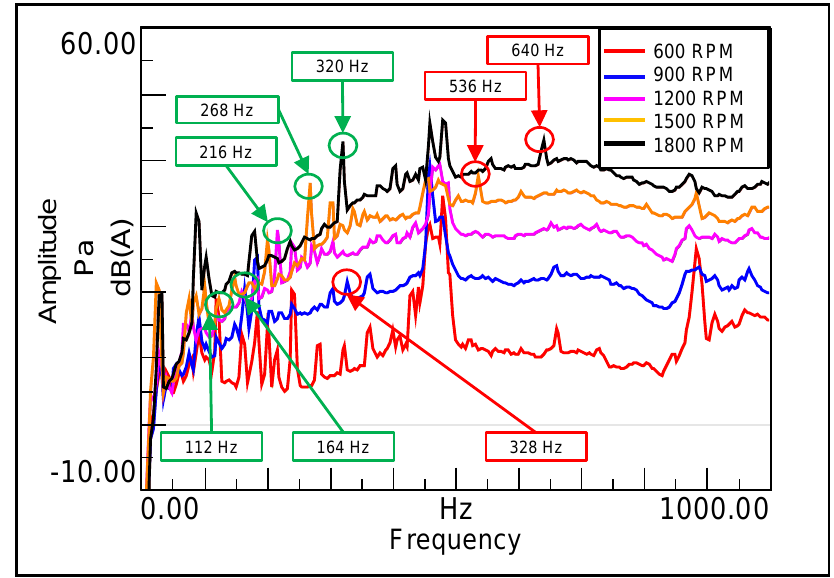
Figure 11. Acoustic auto-power spectrum from fan side microphone with RMS dB(A) values at 600, 900, 1200, 1500, and 1800 RPM .